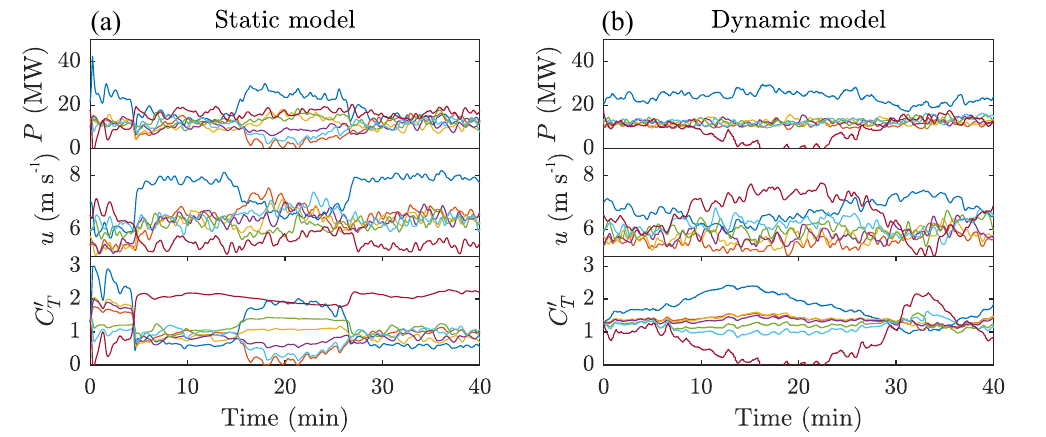
Figure 7. Comparison of static-model (a) and dynamic-model (b) control methods for the RegA.D4.IC2.TS simulation case. Each panel shows the controlled LES wind farm model power production, rotor-averaged velocity, and thrust coefficients by row: row 1 (dark blue), row 2 (orange), row 3 (yellow), row 4 (purple), row 5 (green), row 6 (light blue), and row 7 (brown).